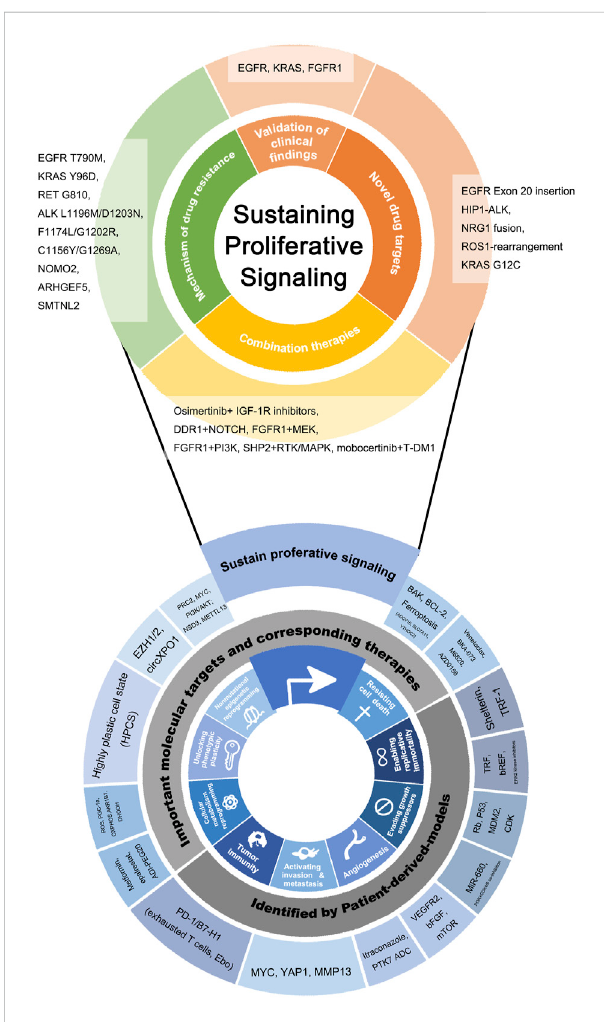
Novel molecular targets and novel drugs discovered or validated by patient-derived lung cancer models, listed according to hallmarks of cancer as the framework. At the bottom of the fi gure, the inward ring represents the framework of this review and is composed of the hallmarks of cancer put forward by Hanahan et al. The hallmarks that are the most closely relevant to patient-derived models are selected. The outward ring represents signi fi cant genes, molecules, drugs, and biological behaviors involved in patient-derived models related basic and clinical research. Findings on Sustaining proliferative signaling were particularly plentiful and clinically meaningful, so the partial “ zoom-in ” was performed and the fi ndings were subdivided by clinical